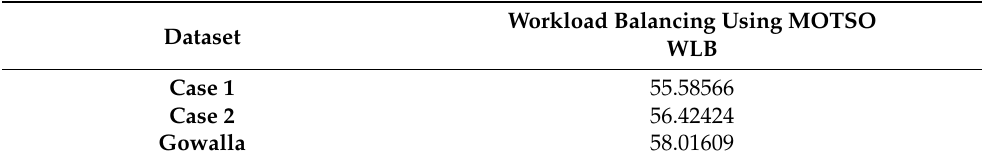
Table 12. The results of the standard deviation of the workload balance (WLB) using the MOTSO